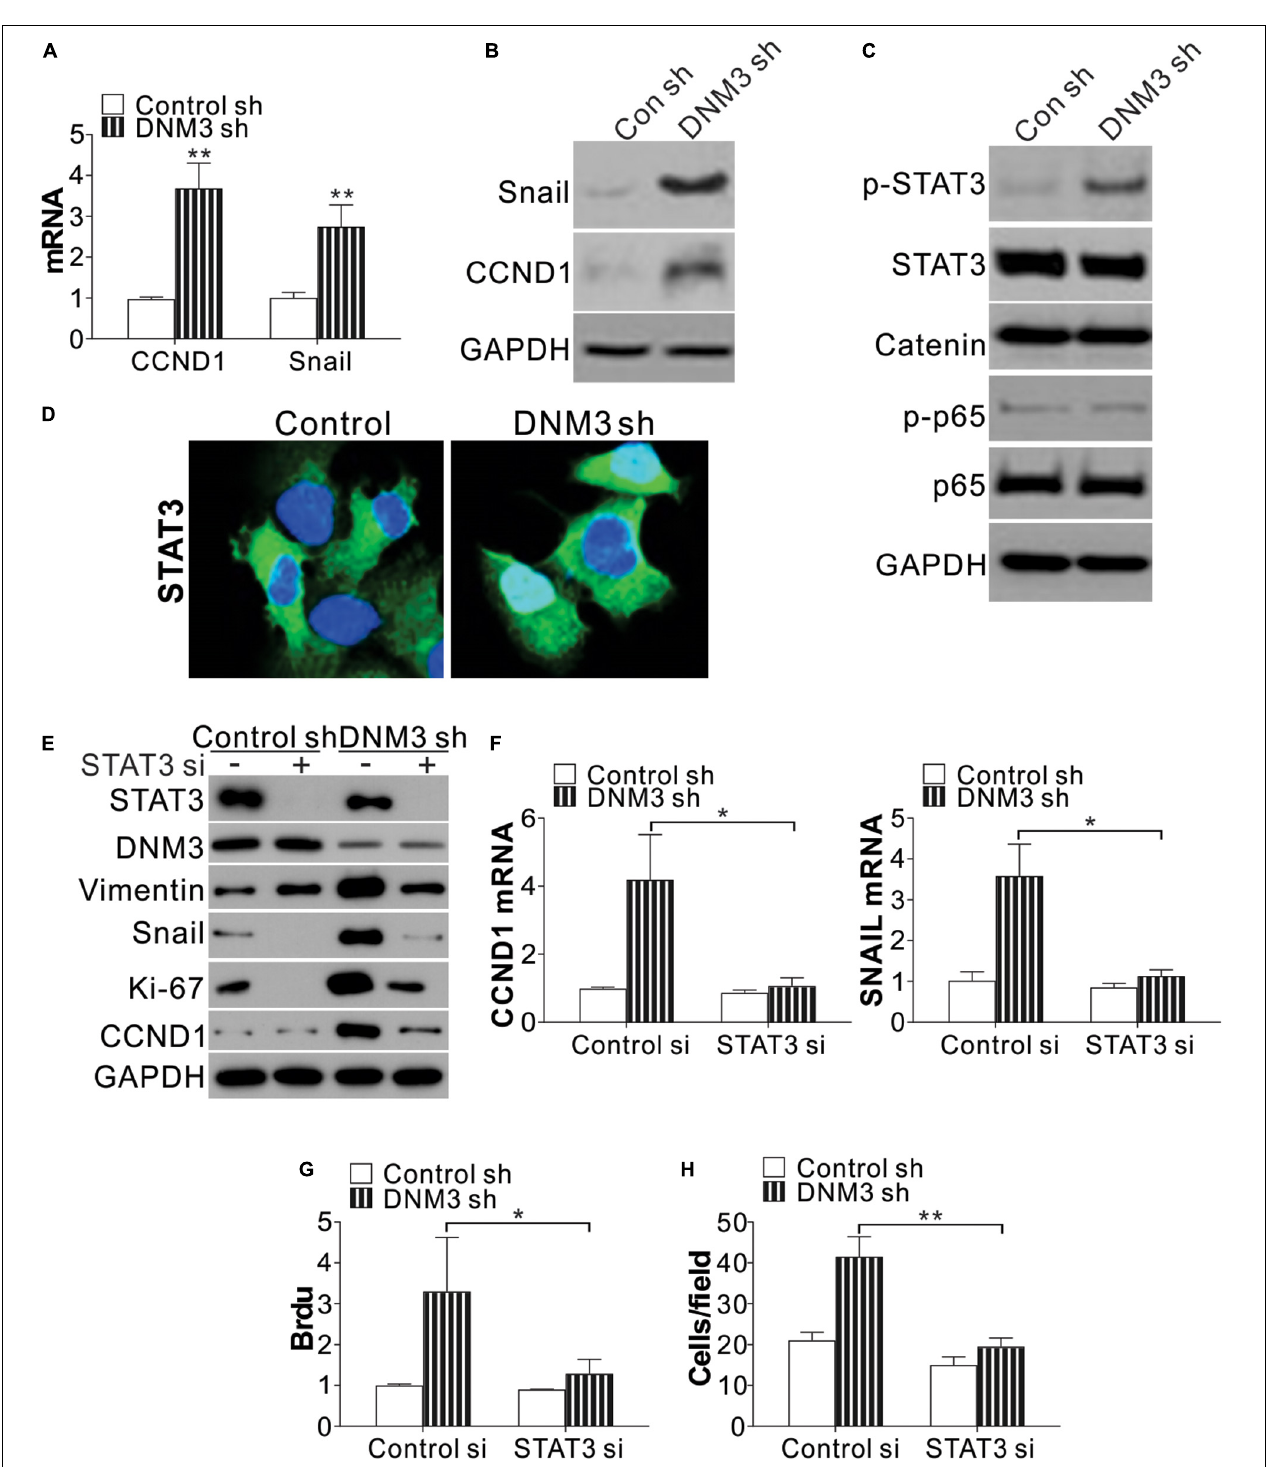
FIGURE 4 | Silencing of DNM3 leads to STAT3 activation. (A) mRNA levels of CCND1 and SNAI1 in H1299 cells with or without DNM3 shRNA transfection. (B) Protein levels of CCND1 and SNAI1 in H1299 cells with or without DNM3 shRNA transfection. (C) Protein level of p-STAT3, STAT3, beta-catenin, p-p65, and p65 in H1299 cells with or without DNM3 shRNA transfection. (D) Immunostaining of STAT3 in H1299 cells with or without DNM3 shRNA transfection. (E–H) H1299 cells with or without stable DNM3 knockdown were transfected with control or STAT3 siRNA. (E) Western blot assay of the indicated proteins. (F) RT-qPCR assay of the mRNA expression of CCND1 and SNAI1 . GAPDH was used as reference gene. (G) Brdu assay of cell proliferation. (H) Transwell assay of the migration of the cells. Each experiment was repeated 3 times. * p < 0.05; ** p < 0.01.